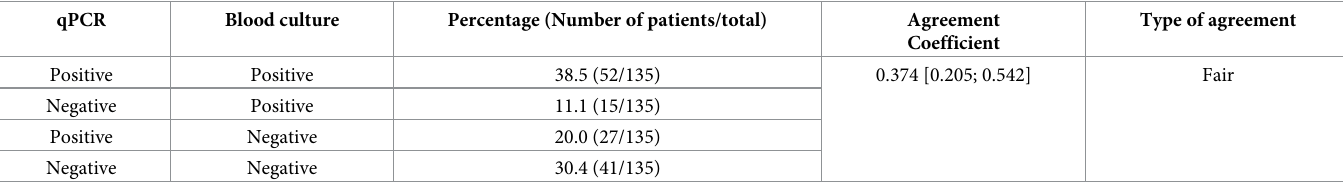
Table 4. Percentage of agreement, point and interval estimates of kappa coefficient of 135 blood samples obtained from 91 Chagas disease patients from different endemic regions of the state of Minas Gerais (southern Brazil). qPCR Blood culture Percentage (Number of patients/total) Positive Negative Positive